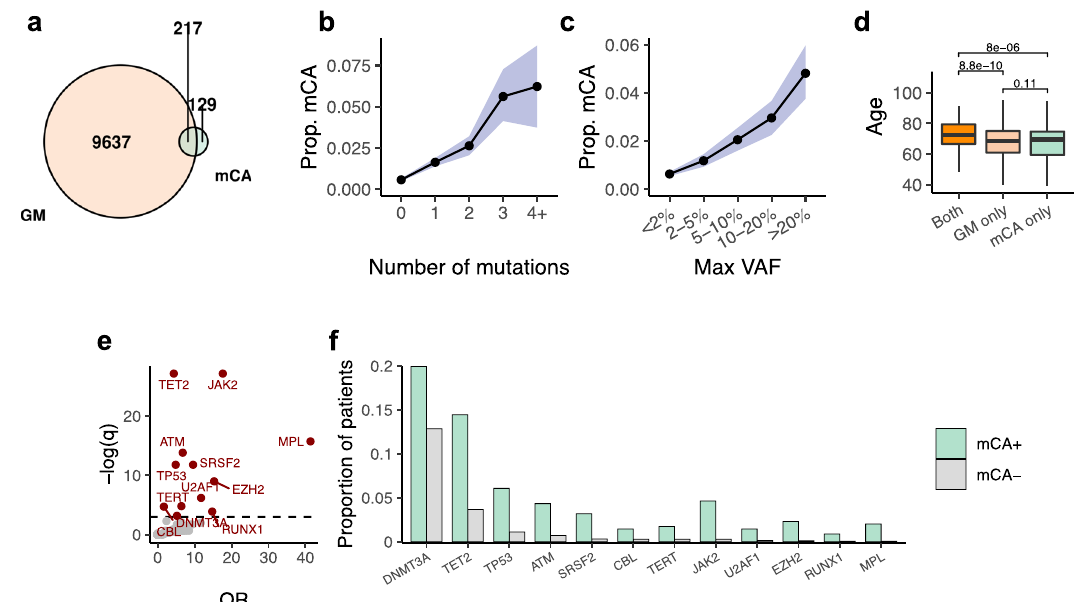
Fig. 2 Global characteristics of mCA in relation to gene mutations. a Overlap between CH cases carrying gene mutations (GMs) and chromosomal alterations (mCAs). Number of subjects are shown in black. b , c The prevalence of mCA increases with mutation burden and VAF. Observed proportion of mCAs within each subgroup is shown as solid dots; 95% CIs generated from a binomial distribution around the observed proportion are shown in blue shades. Gene mutations in regions affected by mCAs are excluded from this analysis. d Age distribution of subjects with mCA only, gene mutations only, and both types of mutations. Unadjusted P values derived from a two-ended Student ’ s t -test are shown. The lower and upper bounds of boxes denote 25 th (Q1) and 75 th (Q3) percentiles of observed ages, respectively. The lower and upper whiskers indicate the minima (Q1 − 1.5*IQR) and maxima (Q3 + 1.5*IQR). e Volcano plot of q values and odds ratios of gene representation in mCA-positive versus mCA-negative cases (Fisher ’ s exact test). Genes signi fi cantly enriched (FDR < 0.05) in mCA subjects are colored in red. f Frequency of gene mutations signi fi cantly enriched in subjects with mCA. Source data are provided as a Source Data fi